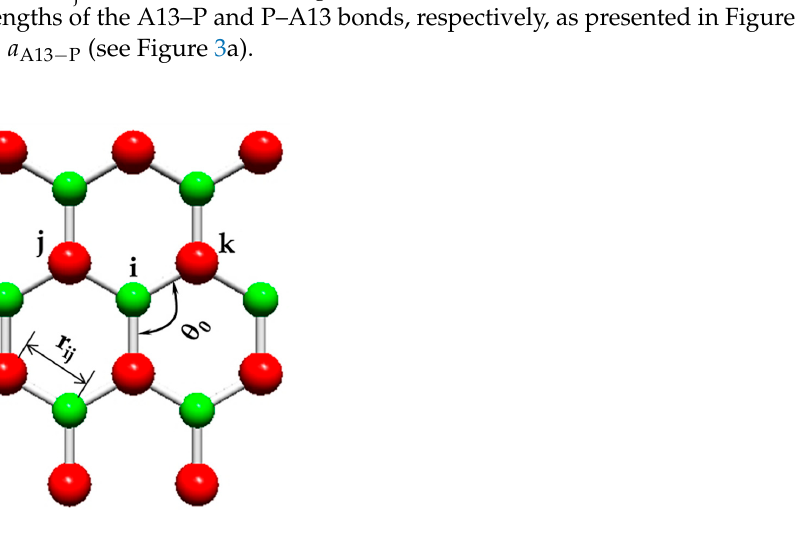
Figure 4. Fragment of the diatomic structure with definition of r ij , r ik and θ 0 . P atoms are represented in green and A13 (B, Al, Ga and In) atoms are in red.